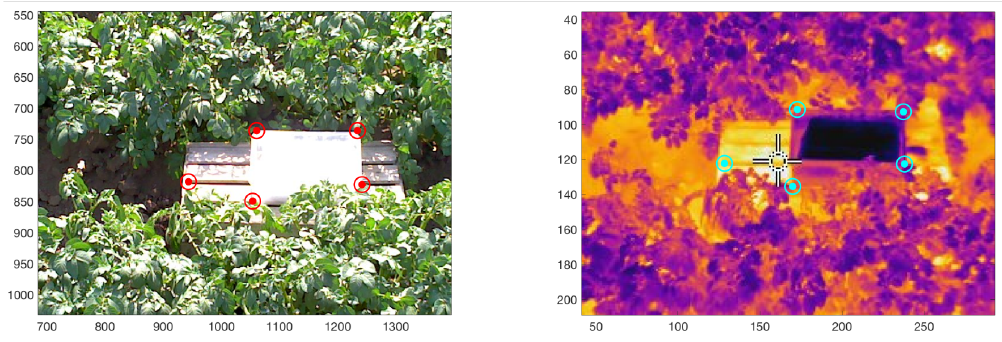
Figure 3. Manually selected, spatially correlated control points in both RGB and IRT images to estimate the geometric transformation parameters: scaling factors ( S x , S y ) and displacement vector ( b x , b y